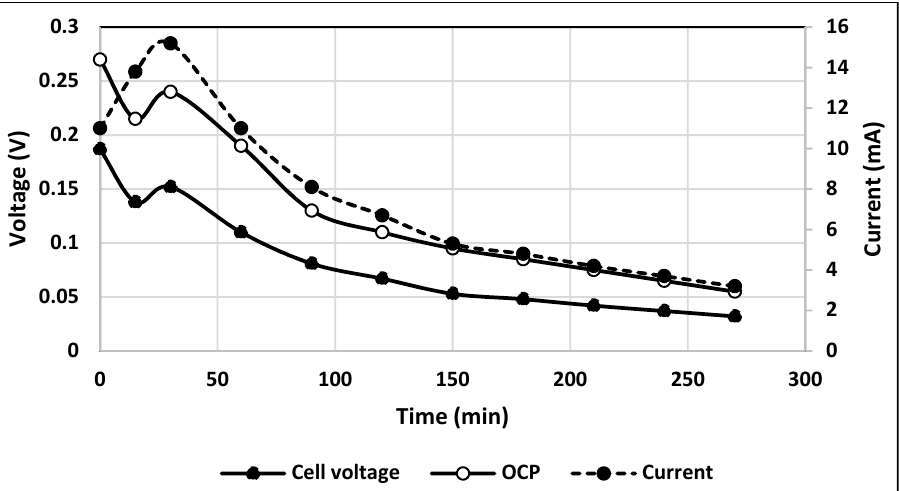
Figure 8. Time profile of cell voltage, open circuit potential (OCP) and electric current for a discharge of a single fuel cell aerated by Venturi tube ejector. Anode is doped by zirconia. Feeding flow rate for cathode compartment 1 dm 3 /h. Feeding sulfide concentration 55.4 mg dm − 3 . Feeding flow rate 0.2 dm 3 h − 1 . Load resistance 10 Ω . Temperature 20 °C.